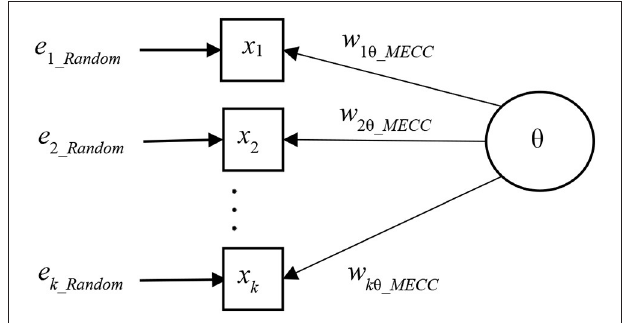
FIGURE 3 | MEC-corrected one-latent variable measurement